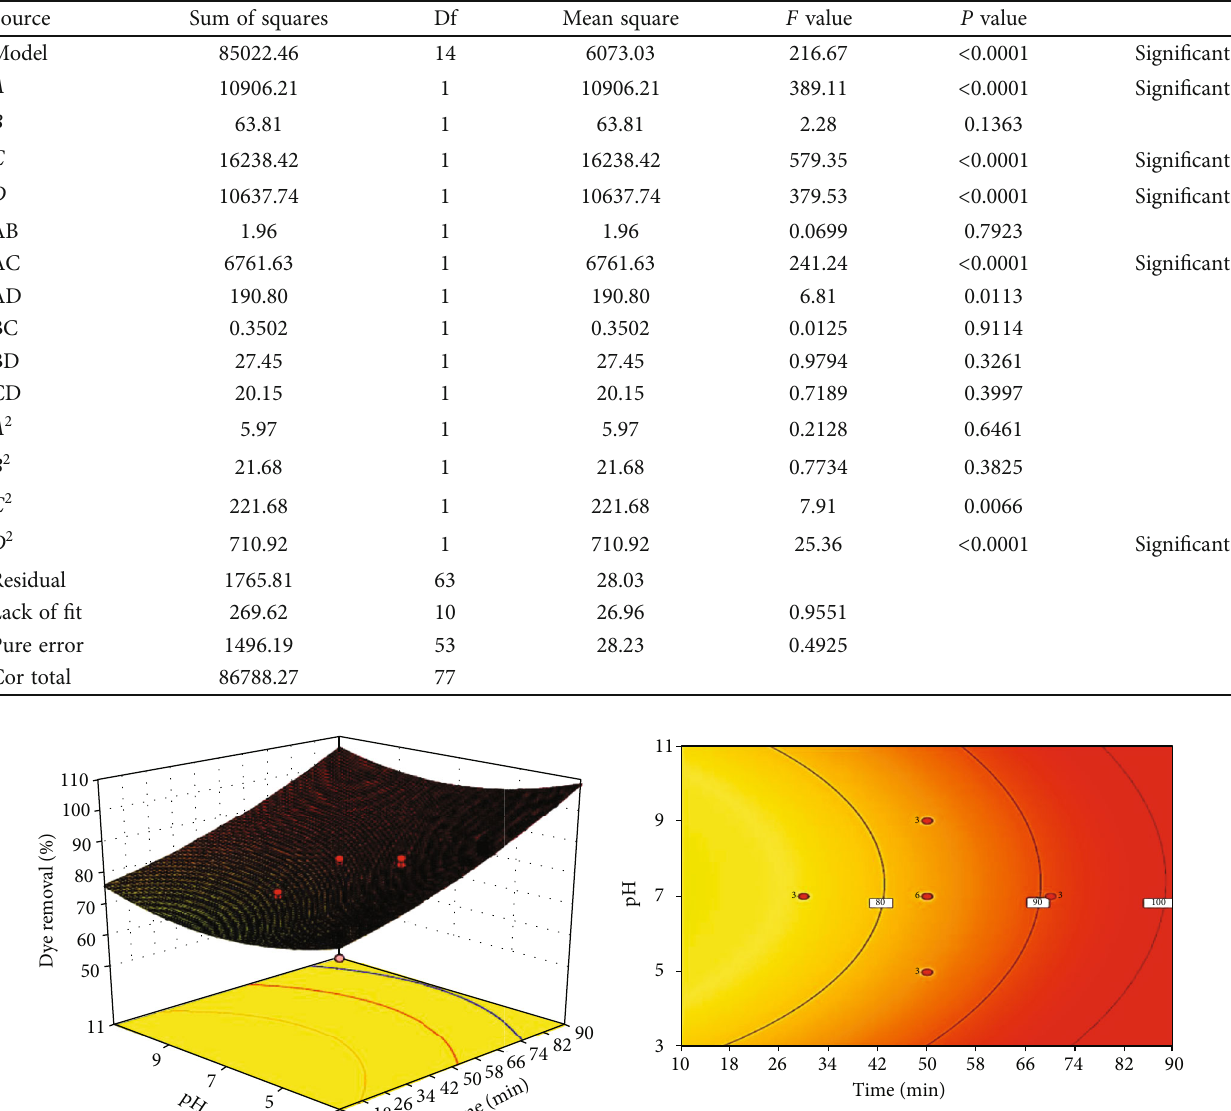
Table 3: Statistical parameters and ANOVA results using Design-Expert 11.0.0 for the studied variables.